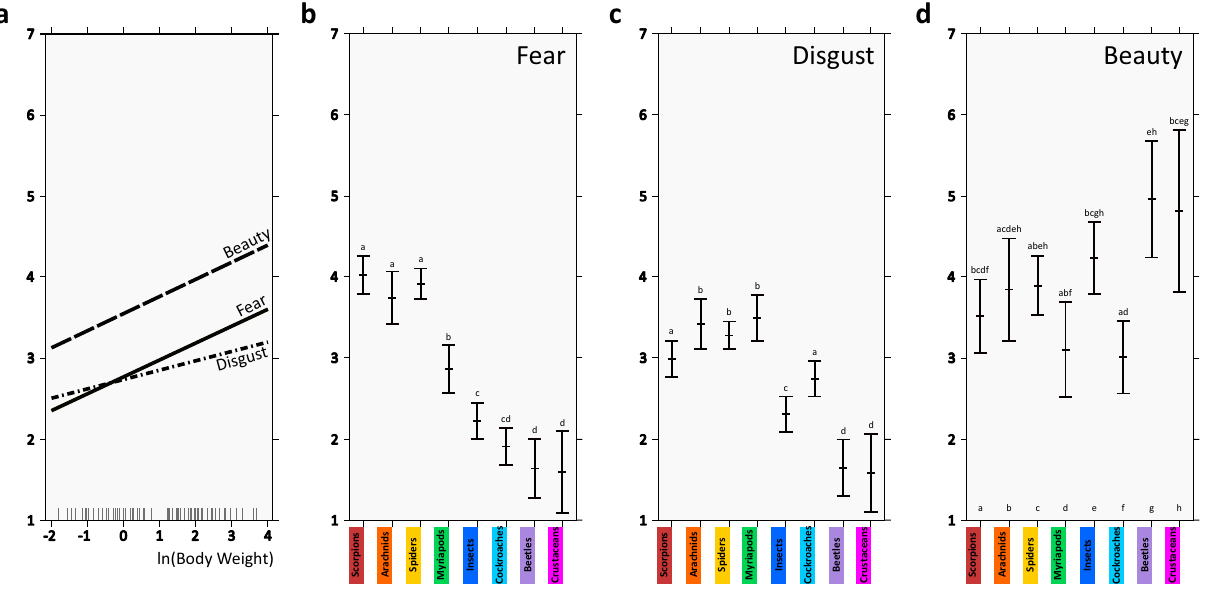
Figure 1. Effects of body size and higher taxa on mean fear, disgust, and beauty scores. ( a ) Effect of body size (expressed as natural logarithm of body weight) on mean fear, disgust, and beauty scores. The estimated slopes are 0.208 (fear), 0.115 (disgust), and 0.210 (beauty). The grey vertical lines on the x axis represent the cases. ( b – d ) Effect of higher taxa on mean fear ( b ), disgust ( c ), and beauty ( d ) scores after accounting for body size; estimated means and standard errors for each of the higher taxa are shown. In ( b ) and ( c ), letters above the whiskers signal no significant difference (α = 0.05) between the higher taxa sharing the same letter. In d, each higher taxon is assigned a unique letter; presence of the letter above the whiskers signals no significant difference (α = 0.05) between the respective